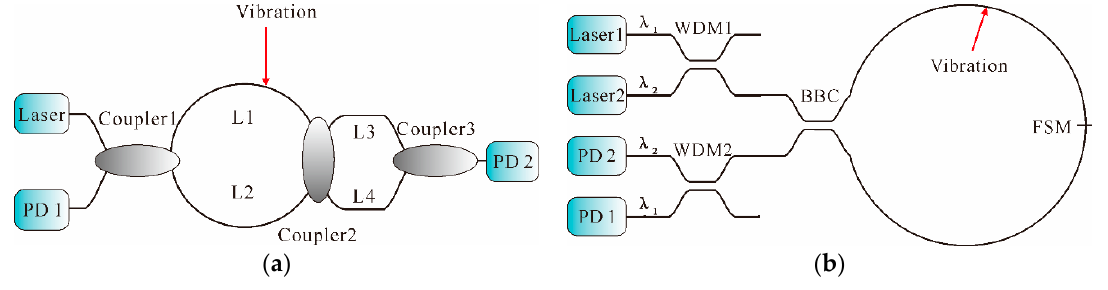
Figure 5. The combination of interferometric techniques: ( a ) Sagnac–MZI, adapted from Chtcherbakov et al. [73]; ( b ) Sagnac–MI, adapted from Spammer et al. [77].